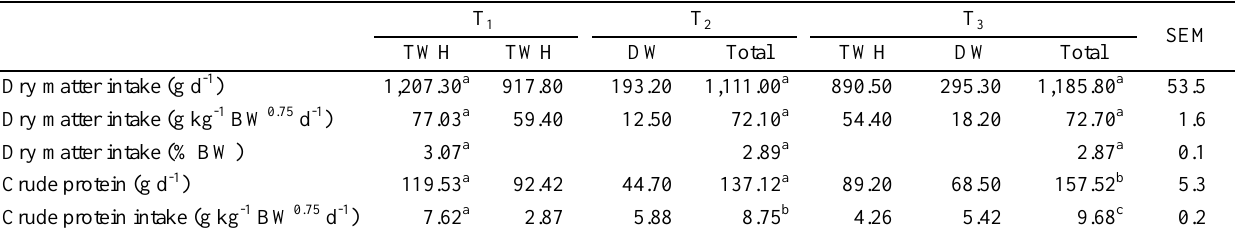
Table 2. Dry matter and crude protein intake of ewes fed Taiwan grass hay alone or supplemented with